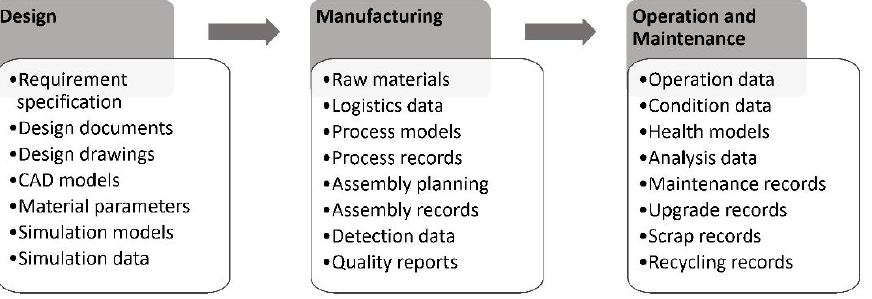
Figure 2. Schematic diagram of data generated by mechanical products at each stage of the lifecycle.